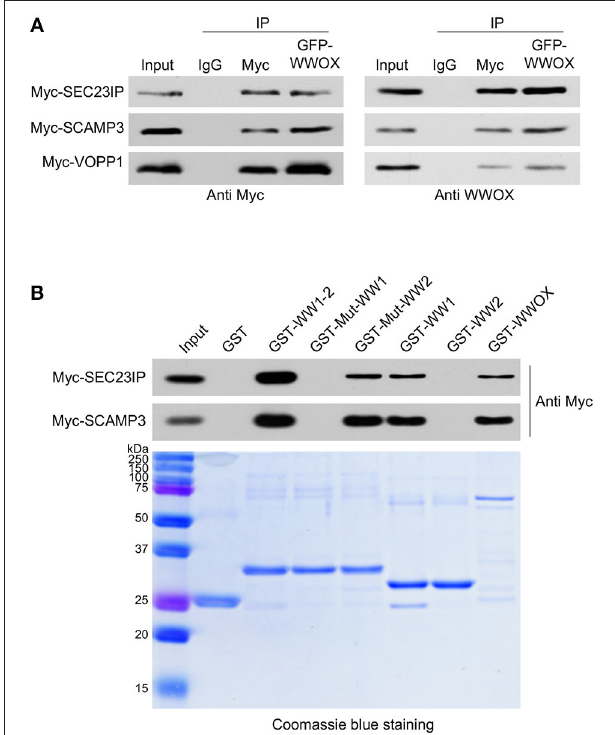
FIGURE 3 | (A) Direct physical interaction between WWOX and SEC23IP, SCAMP3, and VOPP1 proteins. Reciprocal co-immunoprecipitation of GFP-WWOX and Myc-SEC23IP, Myc-SCAMP3 or Myc-VOPP1 in HEK293T cells. Cells were co-transfected with either 1 µ g of Myc-DDK-VOPP1, Myc-DDK-SCAMP3, or Myc-DDK-SEC23IP along with 1 µ g of GFP-WWOX plasmid. After 36h transfected cells were lysed and were immunoprecipitated with either rabbit IgG (control), anti-Myc, or anti-GFP antibodies. The immunoprecipitates were immunoblotted with anti-Myc or anti-WWOX antibodies as indicated. (B) Western blot and corresponding Coomassie blue staining of GST pull-down assay. HEK293T cells were transfected with either Myc-SEC23IP or Myc-SCAMP3 expression vectors. Cell lysates were subjected to pulldowns with the indicated GST fusion proteins: either wild-type WW domains, i.e., WW1 + WW2 (GST-WW1-2); mutant WW1 domain (GST-Mut-WW1), i.e., WW1 W44F/P47A + WW2 WT; mutant WW2 domain (GST-Mut-WW2), i.e., WW1 WT + WW2 Y85A/P88A; WW1 WT (GST-WW1), WW2 WT (GST-WW2), full length wild-type WWOX (GST-WWOX), or